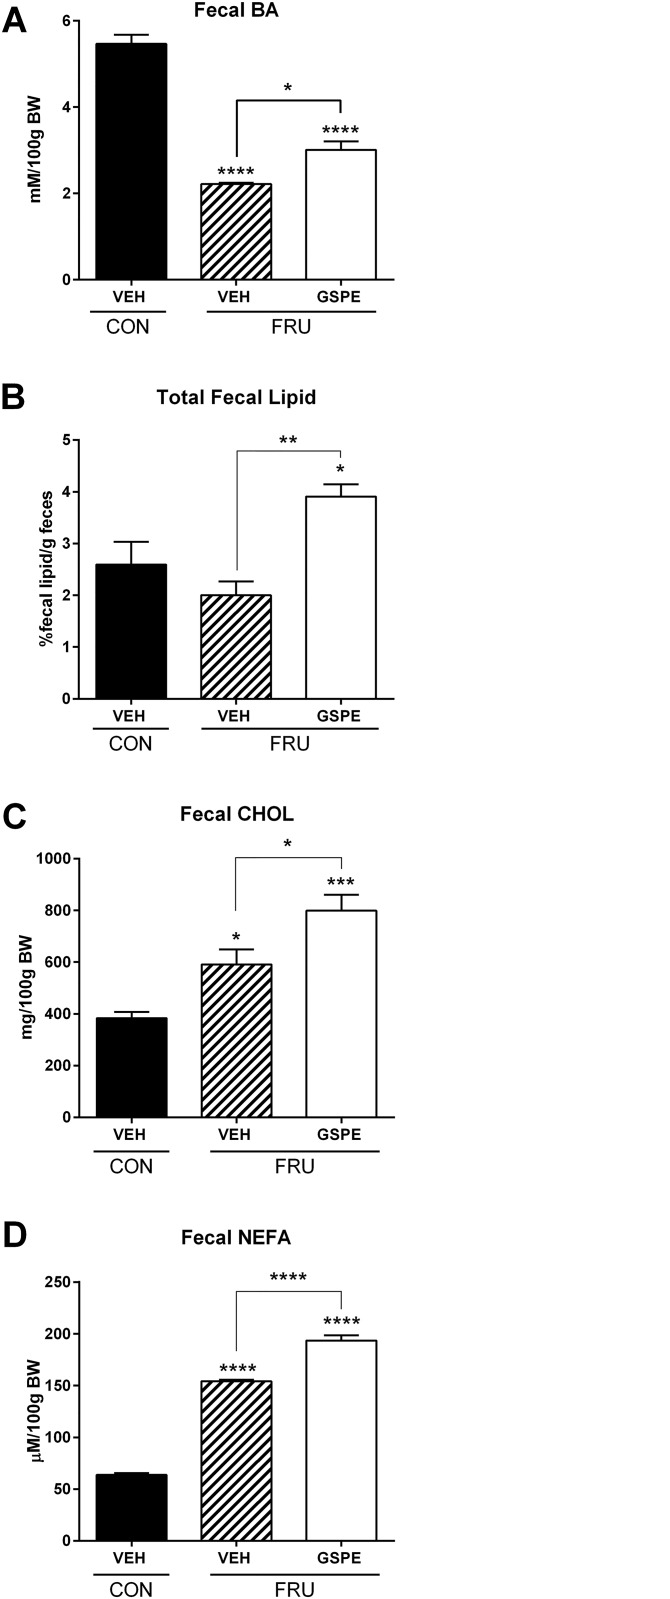
GSPE increases fecal bile acid, total fecal lipid, cholesterol and fatty acid excretion.Fecal (A) bile acids (BA), (B) total fecal lipid, (C) cholesterol (CHOL) or (D) non-esterified fatty acids (NEFA) were analyzed. *p<0.05, **p<0.01, ***p<0.001 and ****p<0.0001.